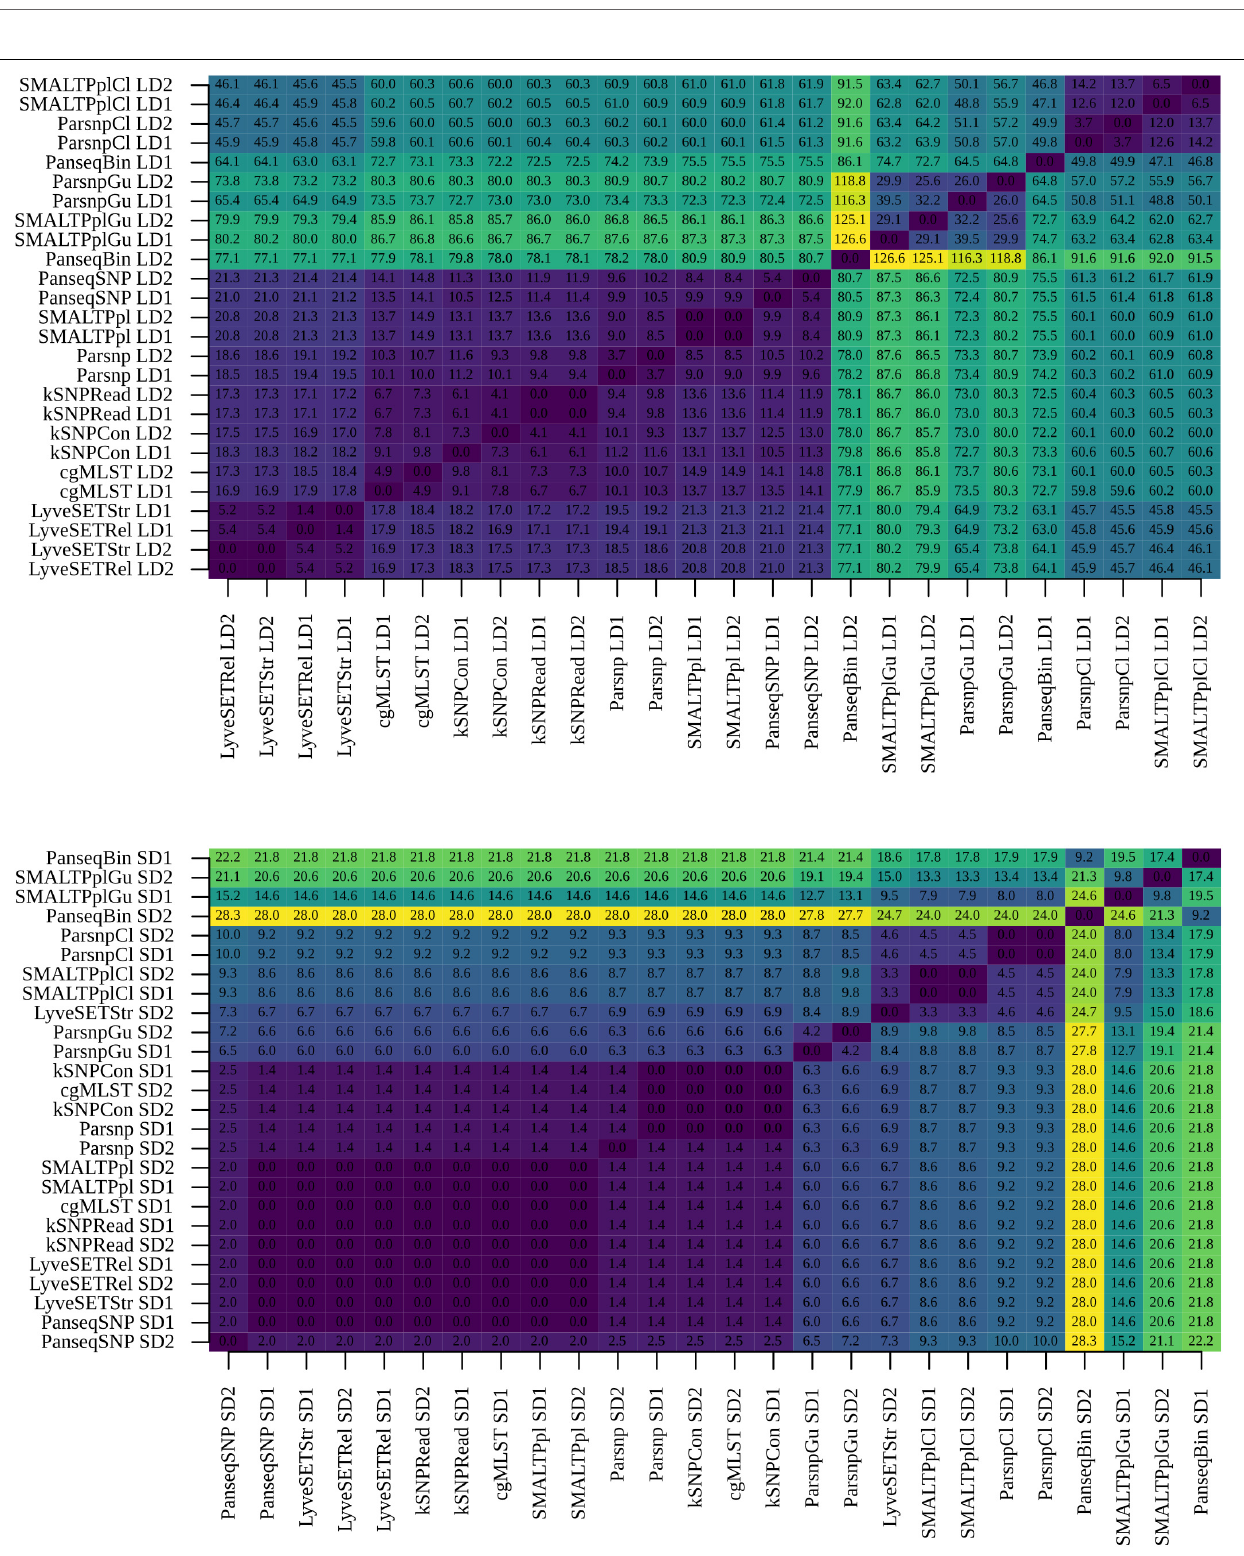
Frontiers in Microbiology |